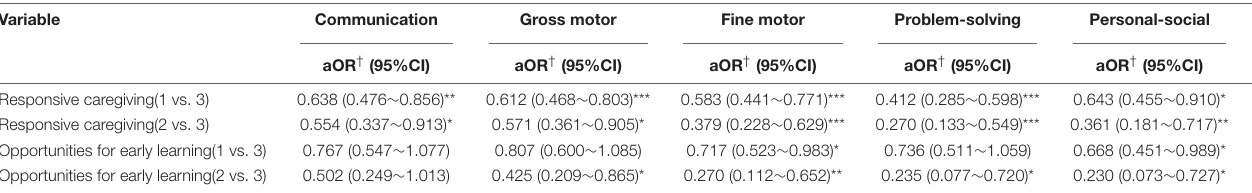
TABLE 2 | The relations between responsive caregiving or opportunities for early learning and infant development delay.